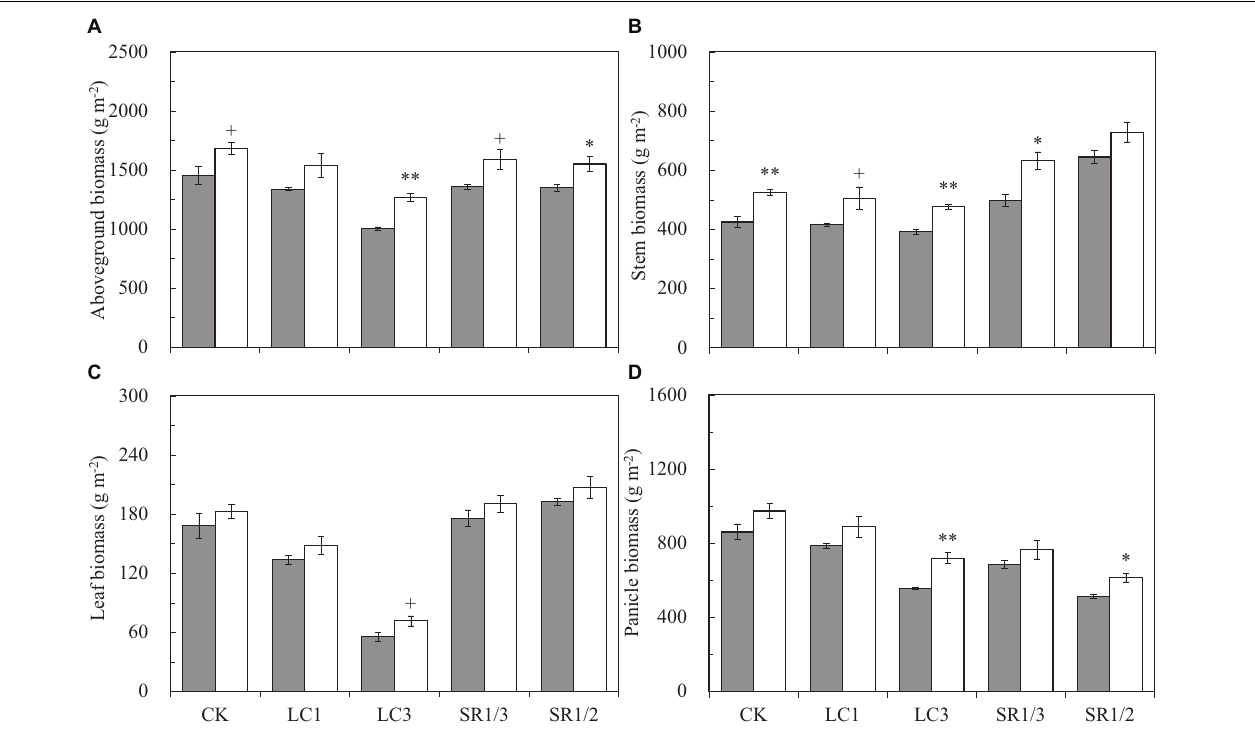
FIGURE 4 | Aboveground biomass (A) , stem biomass (B) , leaf biomass (C) , and panicle biomass (D) of WYJ27 per unit area at maturity affected by elevated CO 2 and different source-sink treatments in 2017. Each bar in the figure represents the mean values across three plots for ambient CO 2 (aCO 2 , filled square) or elevated CO 2 (eCO 2 , aCO 2 + 200 ppm, unfilled square); vertical bars represent standard error ( n = 3). CK, no leaf cutting or spikelet removing; LC1, cutting off the flag leaf; LC3, cutting off top three leaves; SR1/3, removing one branch in every three branches of a panicle; SR1/2, removing one branch in every two branches of a panicle. ** P < 0.01, * P < 0.05, + P <